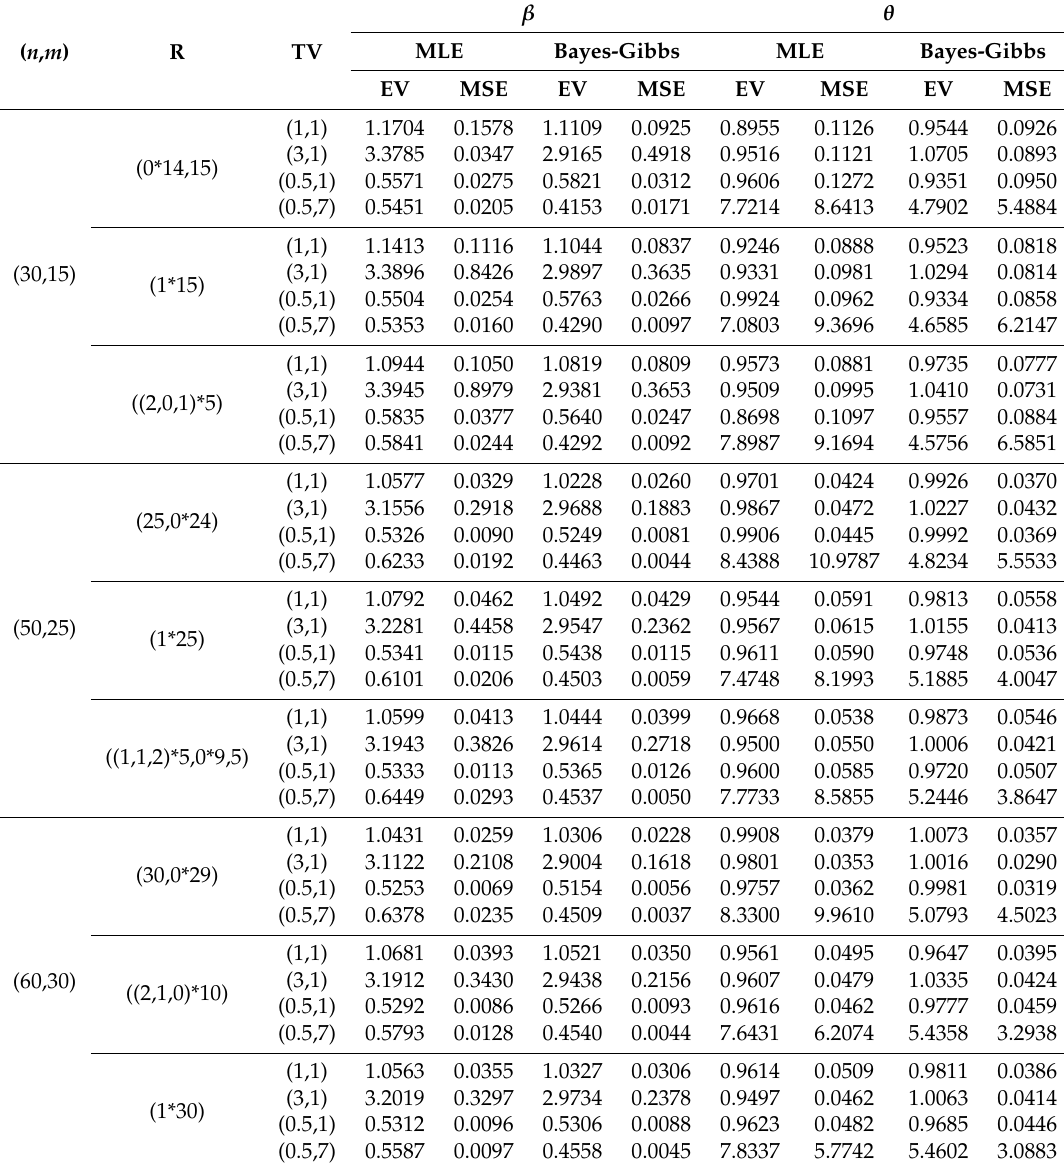
Table 3. EVs and MSEs of point estimators when T =